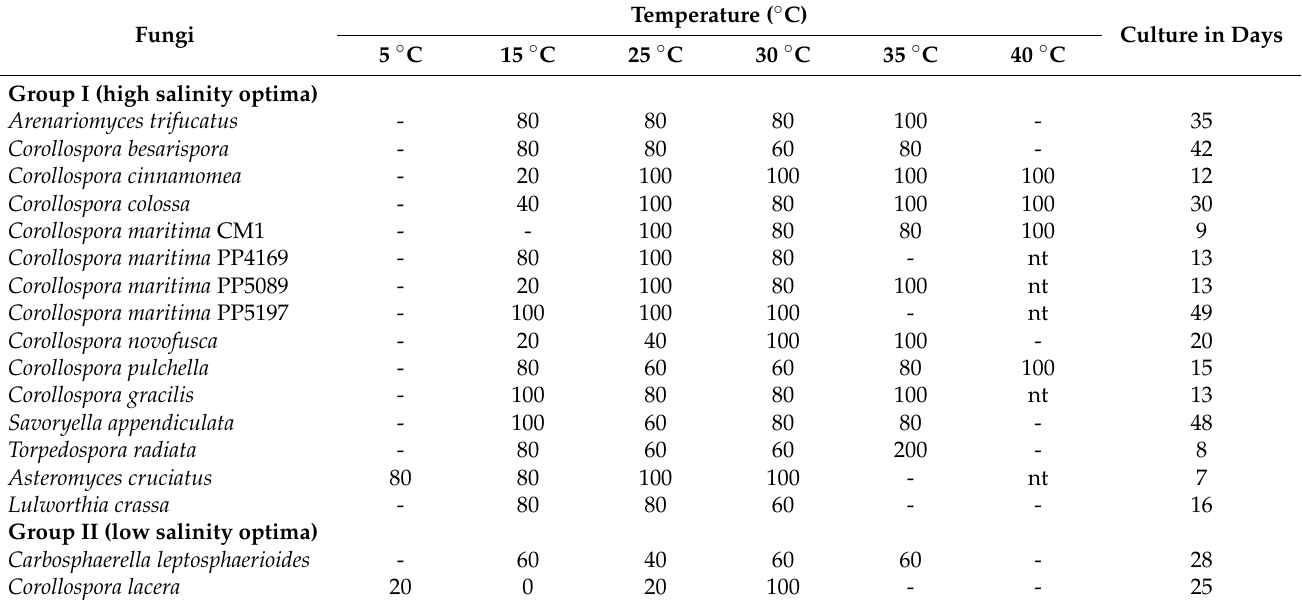
Table 1. The optimum salinities (% seawater) for the growth of marine fungi at each temperature investigated. NB: All data used in this table were taken from the linear part of the growth curve. -: no growth; nt: not